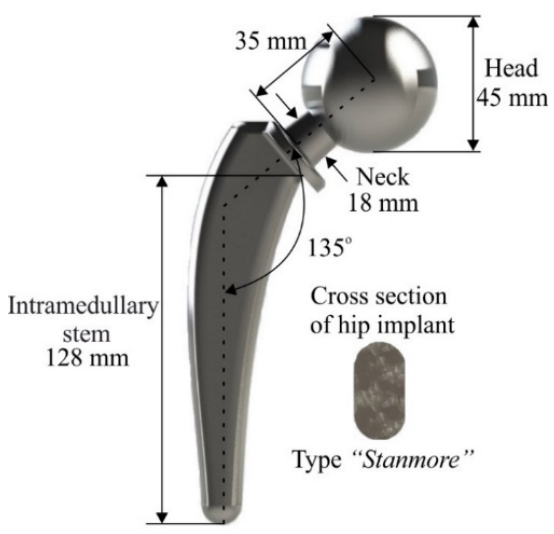
Figure 2. Design of hip implant.